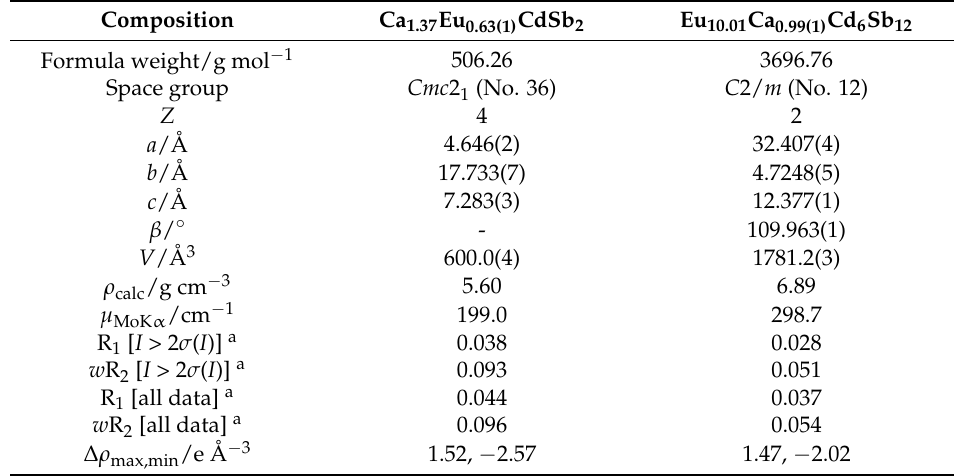
Table 4. Data collection details and selected crystallographic data for Ca 1.37 Eu 0.63(1) CdSb 2 and